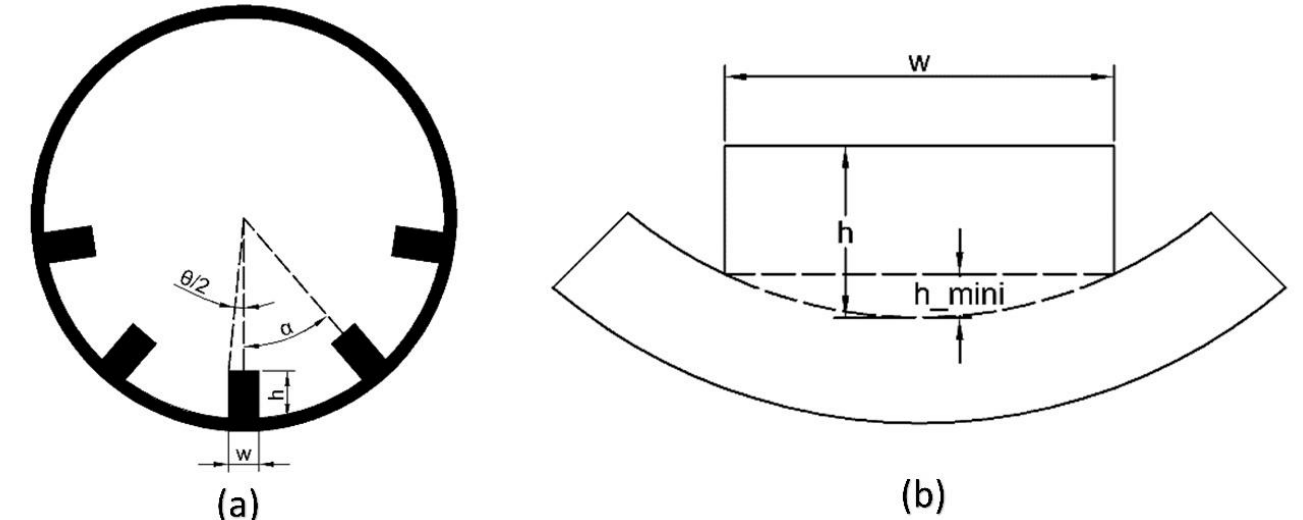
Figure 2. Two geometrical constraints: ( a ) the angle α is considered superior to θ ; ( b ) the fin height h is considered to be greater than h_min .